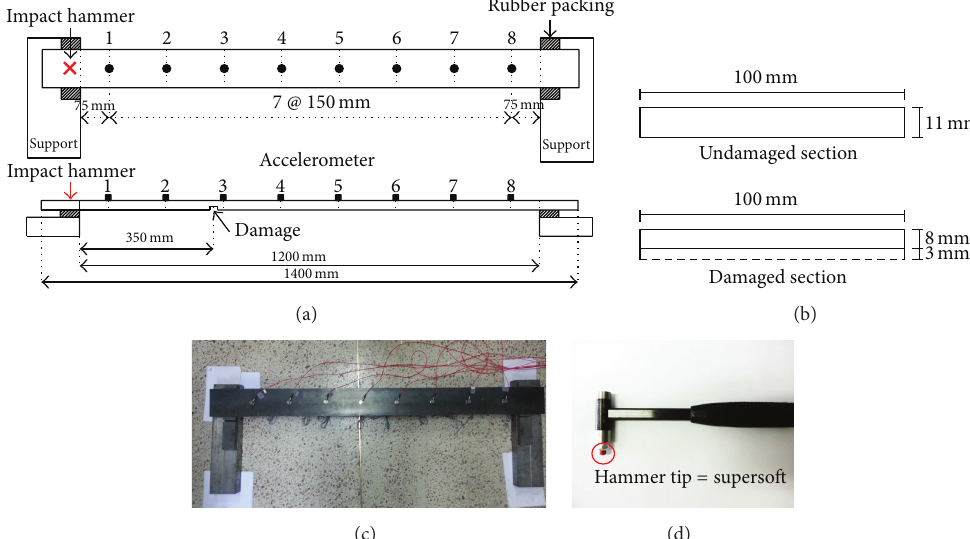
Figure 11: Test beam: (a) plan view, (b) section, (c) photo of test beam, and (d) impact